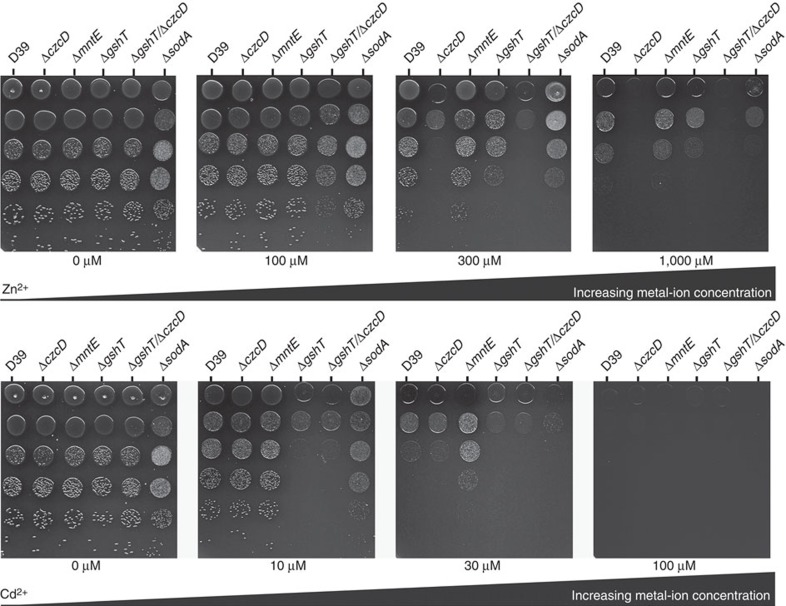
Phenotypic impact of metal ions on S. pneumoniae growth.Drop test analysis of S. pneumoniae wild-type (D39), ΔczcD, ΔmntE, ΔgshT, ΔgshT/ΔczcD and ΔsodA on blood agar (BA) supplemented with: 0, 100, 300 and 1,000 μM ZnSO4 or 0, 10, 30 and 100 μM CdCl2. Cells were grown and adjusted to A600 of 0.4 and were serially diluted. Drops (5 μl) were spotted onto the BA plate, starting from the 100 dilution (top) down to the 10−5 dilution (bottom).